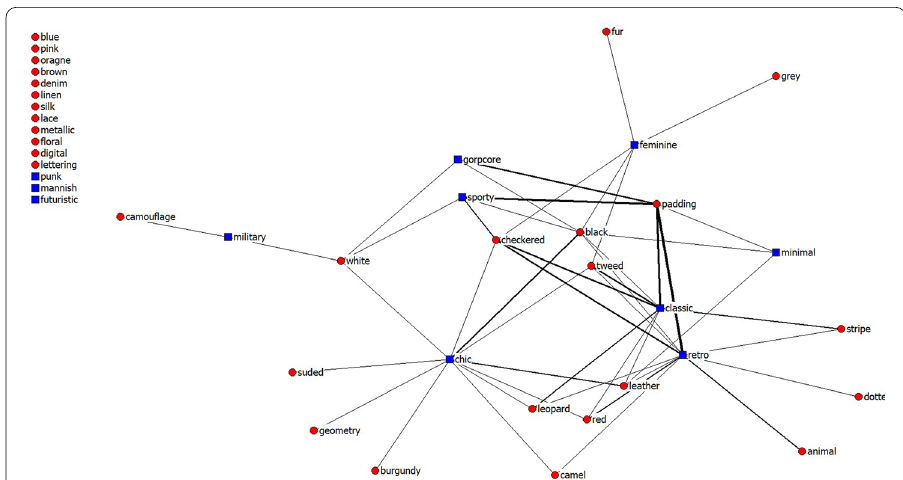
Fig. 3 Semantic network analysis results of 2-mode data on the jacket design feature (2018 fall/winter season). Triangles represent styles, and squares represent other design features (colors, fabrics, and patterns). The thickness of the lines indicates the strength of the links in terms of co-occurrences. Padding has a high degree centrality of 0.455, and it shows strong ties with other design features, considered the